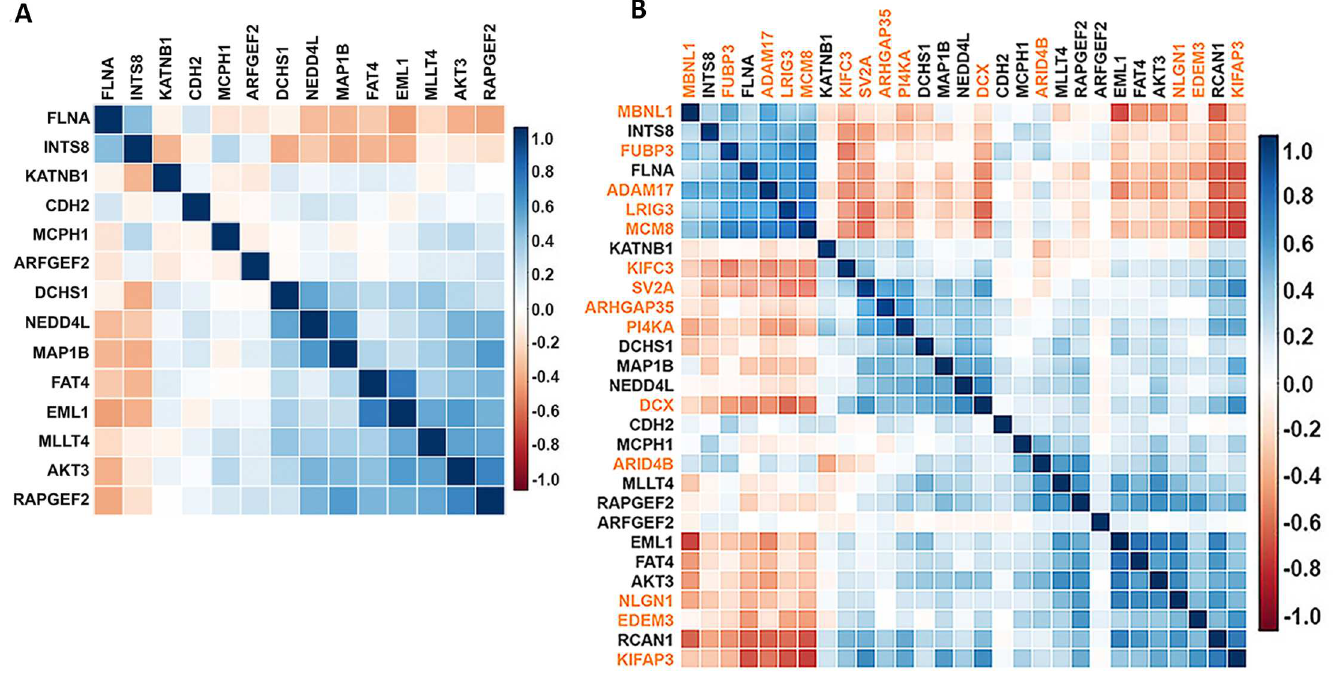
Fig 4. Ordered correlation matrices for the PVNH query and the fourteen loci significantly co-expressing within this node. Pairwise Pearson’s correlation represented as a matrix between (a) pairs of the 14 genes within the PVNH gene set (Methods) and (b) the human PVNH query plus the 14 genes whose co-regulatory patterns significantly exceed the eFDR in both the Kang and Miller transcriptomic datasets. Genes are ordered according to hierarchical clustering, with the most positive (+1) and negative (-1) co-regulatory interactions represented as blue and red squares, respectively.